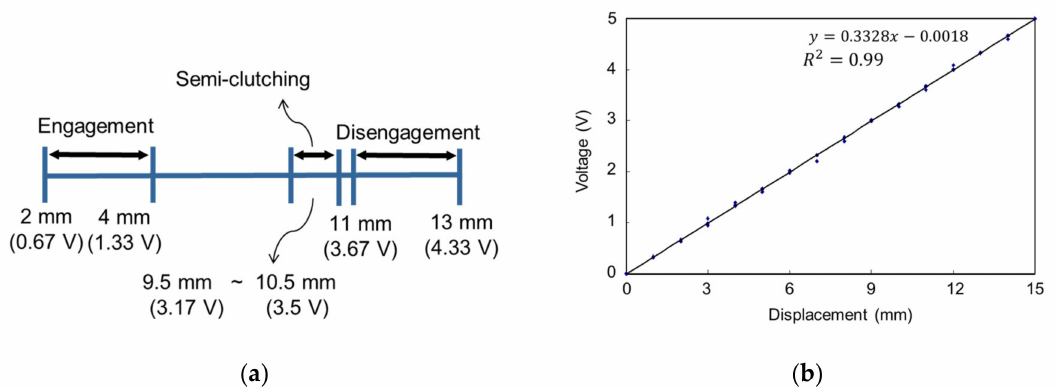
Figure 4. ( a ) Potentiometer values; and ( b ) calibration result according to position for clutch actuator.